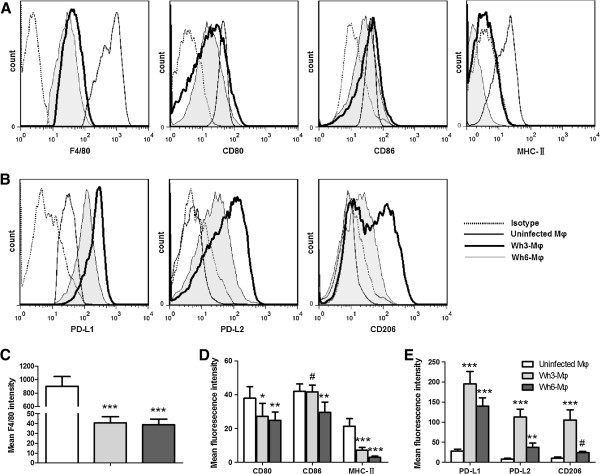
Cell surface markers in uninfected macrophages, Wh3-Mφ and Wh6-Mφ. (A) After three days postinfection, mice were euthanized and PECs were harvested. Three hours later adherent peritoneal macrophages were collected and stained for F4/80, CD80, CD86 and MHC class II. (B) As in (A), Wh3-Mφ and Wh6-Mφ were stained for F4/80, PD-L1, PD-L2 and CD206. Flow cytometry graphs show histograms of F4/80-gated macrophages (dotted lines, the isotype control; solid lines, uninfected macrophages; heavy lines, Wh3-Mφ; tinted and hairline, Wh6-Mφ). (C, D and E) MFIs of F4/80 (C), CD80, CD86 and MHC class II molecule (D), PD-L1, PD-L2 and CD206 (E) on uninfected macrophages, Wh3-Mφ or Wh6-Mφ are displayed (#p>0.05, *p<0.05, **p<0.01,***p<0.001, Wh3-Mφ or Wh6-Mφ vs uninfected Mφ). Data are representative of five independent experiments.